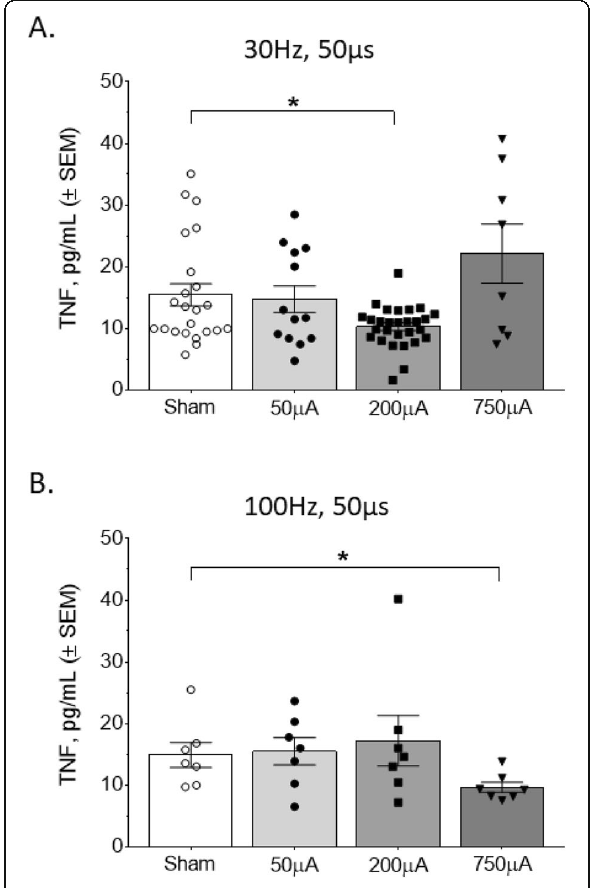
Fig. 2 Specific stimulation amplitude and frequency combinations at 50 μ s pulse widths reduce serum TNF levels. a A significant decrease in TNF, compared to the sham group, was observed with 30 Hz stimulation and a pulse amplitude of 200 μ A. b A significant decrease in TNF was observed at 100 Hz stimulation with a pulse amplitude of 750 μ A. Data is represented as individual mouse data points with mean ± SEM. n = 7 – 29 per group, *, P < 0.05